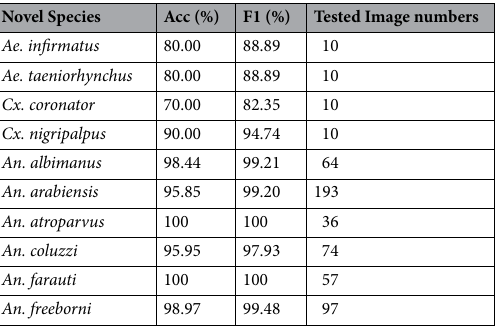
Table 3. Probability of correct attribution of novel species. Acc was short for accuracy and F1 was shoret for